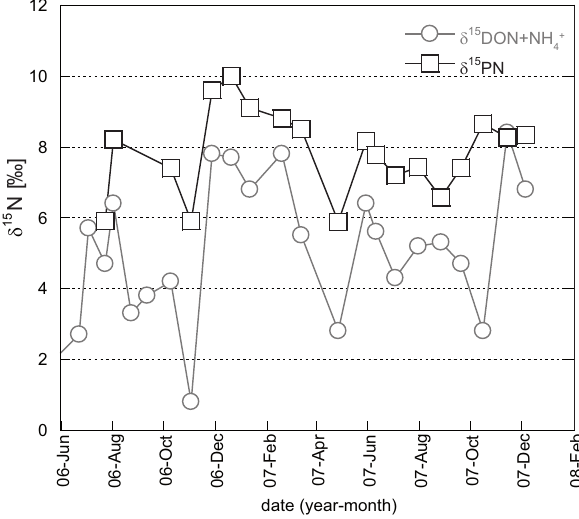
Fig. 3. Relationship between δ 15 N − NO − amine the fractionation factor ratio ε 15 / ε 18 , dashed line represents a 1:1 ratio.